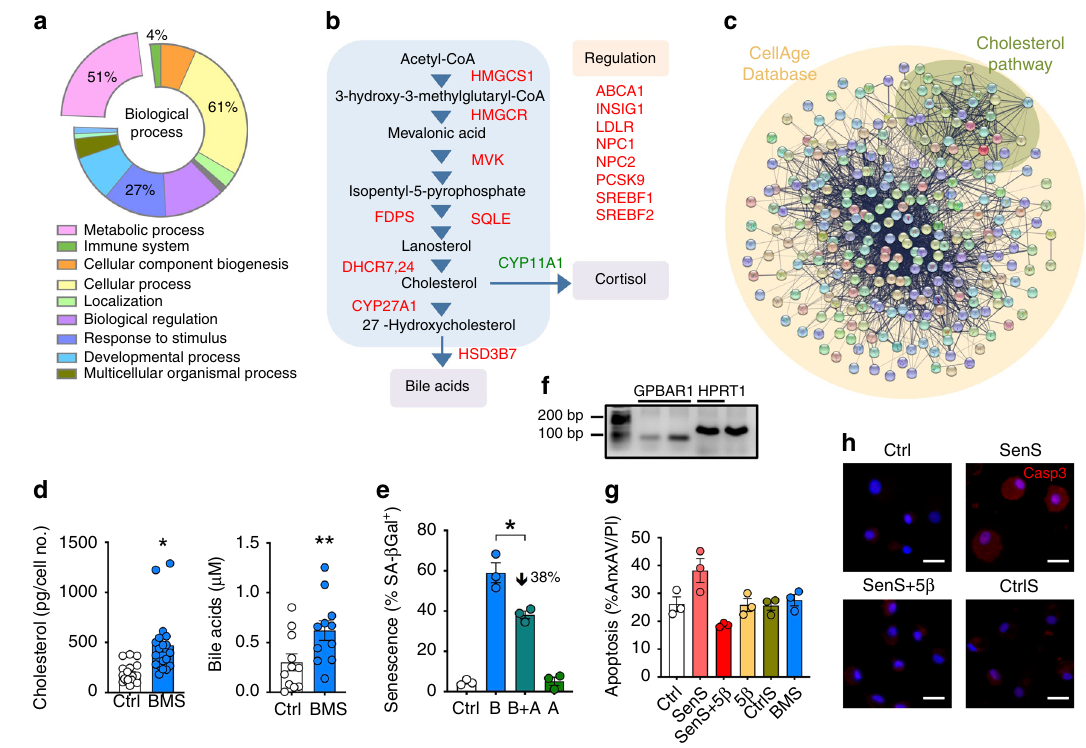
Fig. 5 Role of cholesterol and bile acids in SF senescence. a Functional annotation of all 279 genes included in the CellAge database. b Cholesterol- pathway-related genes identi fi ed by RNAseq of SF treated with 1 μ M BMS for 7 days: red (up-regulated); green (down-regulated). Additional information on these genes is reported in Supplementary Table 3. c Protein – protein interaction (PPI) network constructed with STRING reveals the interactivity between senescence-related genes and the cholesterol pathway. d Levels of cholesterol and bile acids in SF treated with 1 μ M BMS for 7 days were quanti fi ed by enzyme immune-assay. Data are mean ± SE ( n = 11 for cholesterol, n = 11 for bile acids, Student ’ s t -test vs. control, Ctrl; * p < 0.05, ** p < 0.01). e SF were treated with 1 μ M BMS (B) with or without 1 μ M atorvastatin (A) for 7 days and senescence determined by SA- β Gal staining. Data are mean ± SE ( n = 3, one-way ANOVA vs. control, Ctrl; * p < 0.05). f Gene expression of GPBAR1 and reference gene HPRT1 on differentiated human macrophages on two different donors is shown with expected bands at 63 and 130 bp, respectively. g Human macrophages were incubated with supernatants from senescent SF (SenS, from SF treated with 1 µ M BMS for 7 days), with SenS supernatants plus 5 β -cholanic acid (SenS + 5 β ), supernatants from control SF (CtrlS) or directly stimulated with 1 μ M BMS for 5 days. Apoptosis was assessed by fl ow cytometry by measuring annexin A5 and propidium iodide staining. Data are mean ± SE ( n = 3). h Activated caspase-3 was assessed by fl uorescent microscopy on human macrophages treated as in panel g . Scale bars indicate 200 μ m. Source data are provided as Source Data fi